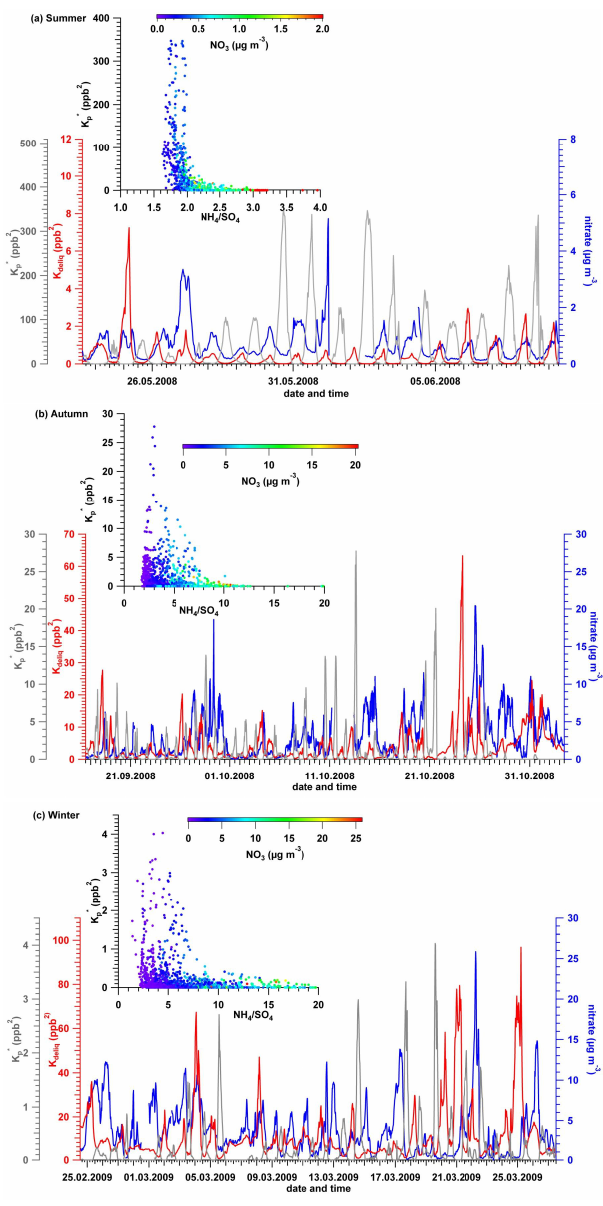
Fig. 8. Time series of the nitrate concentration and the theoretical equilibrium constants ( K ∗ p ( T ) and K deliq ( T )) for pure ammonium nitrate during the three measurement periods ( (a) summer, (b) au- tumn and (c) Winter). The insert scatter plots is the relation between K ∗ p ( T ) and the particulate ammonium to sulfate ratio colored by the nitrate